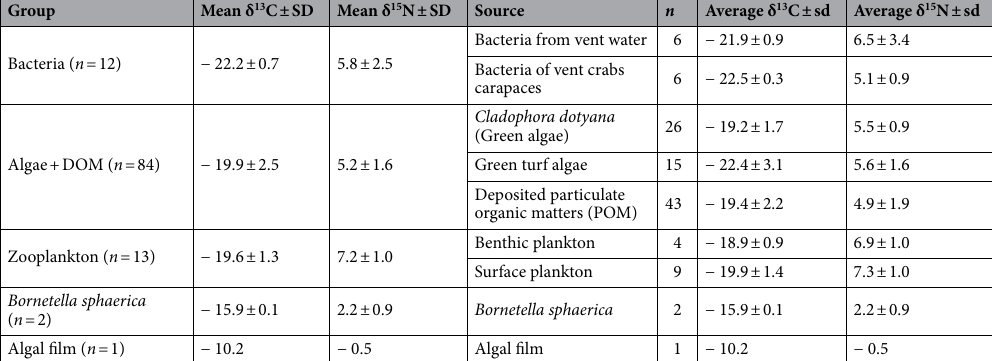
Sea anemone ( Anthopleura